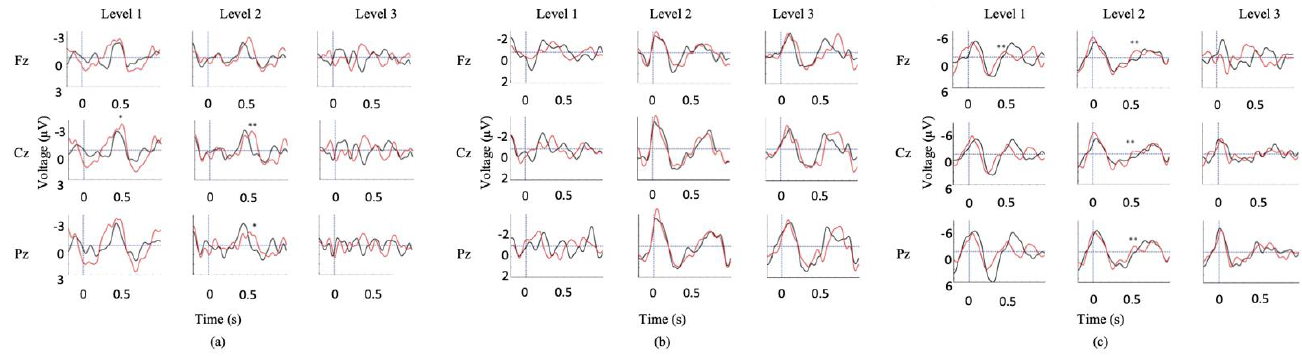
Figure 5. Module 3 ERP responses II. ( a ) Averaged N400 waveforms for auditory PPVT-R stimulus presentation (Session 3), ( b ) Averaged N400 waveforms for fast visual PPVT-R stimulus presentation (Session 4). ( c ) Averaged N400 waveforms for slow visual PPVT-R stimulus presentation (Session 5). Red waveforms are the averaged incongruent stimuli; black waveforms are the averaged congruent stimuli. ** indicates significant difference between congruent and incongruent waveforms ( p < 0.05). Note: a 7 Hz smoothing filter was applied for visualization only.